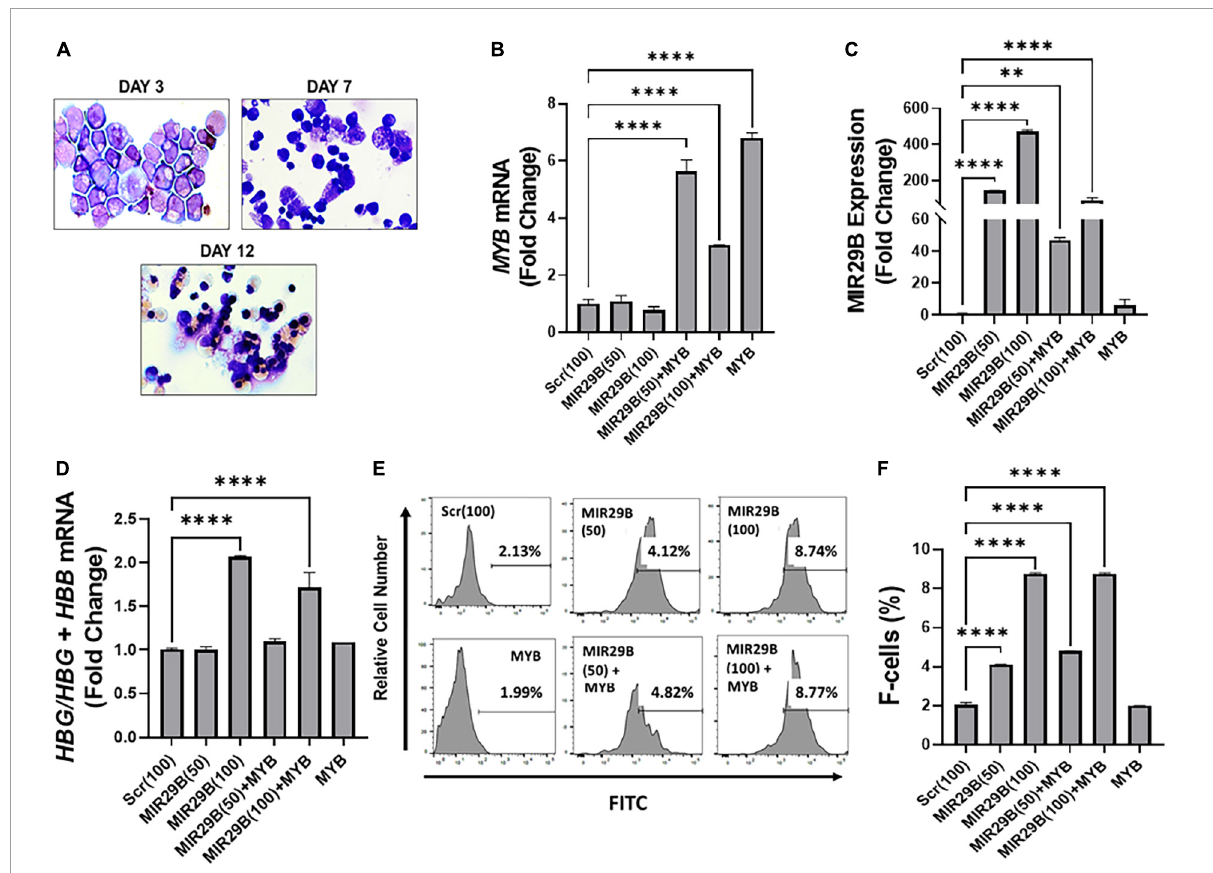
FIGURE3 MicroRNA29B (MIR29B) mediates HBG reactivation via MYB gene silencing in normal human erythroid progenitors. (A) Wright-Giemsa-stained images of human erythroid progenitors ( n = 3) undergoing differentiation at day 3, day 7, and day 12 in vitro . Quantitative RT-qPCR analysis of (B) MYB mRNA relative to β -actin, (C) MIR29B relative to RNU48, and (D) HBG -to- HBB mRNA ratio as a function of HBG / HBG + HBB, (E) Representative histograms from flow cytometry analysis of the percentage of HbF-positive cells following transfection of MIR29B alone or in combination with MYB into primary erythroid progenitors ( n = 3) stained with FITC anti-HbF antibody. (F) Bar graphs showing quantification of the ratio of HbF-to-HbA in erythroid progenitors ( n = 3) transfected with MIR29B alone or in combination with MYB . * P < 0.05, ** P < 0.005, *** P < 0.0005, and **** P < 0.0001 is statistically